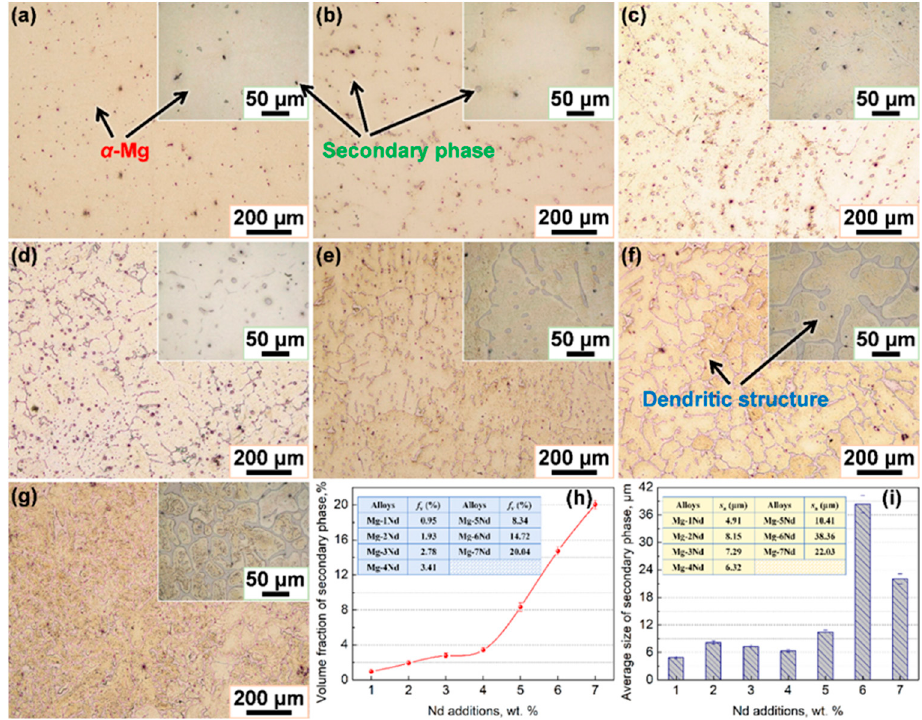
Figure 3. Low- and high-magnification optical micrographs of the microstructure and the secondary phase in different Mg–Nd system alloys: ( a ) Mg-1Nd; ( b ) Mg-2Nd; ( c ) Mg-3Nd; ( d ) Mg-4Nd; ( e ) Mg-5Nd; ( f ) Mg-6Nd; ( g ) Mg-7Nd; ( h ) and ( i ) the volume fraction and average size of secondary phase variation in Mg–Nd system alloys, respectively.